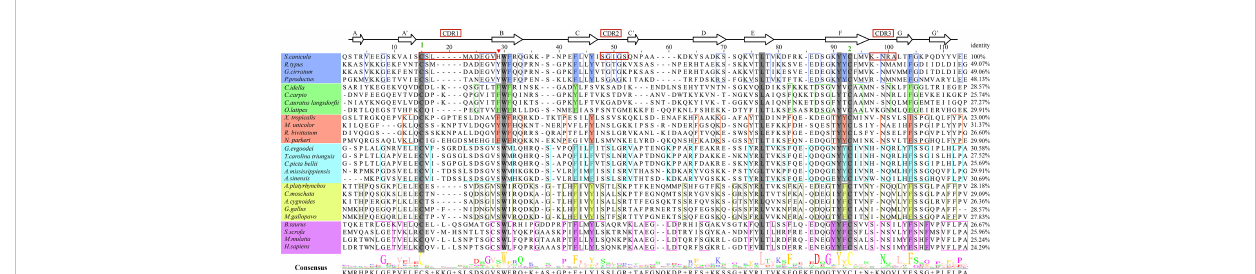
FIGURE 3 Amino acid sequence alignment of Sc CD8 a with CD8 a s from different vertebrate species, with secondary structure elements indicated. Black arrows above the alignment indicate b -strands. Green numbers denote cysteines that form disul fi de bonds, CDRs are outlined with red boxes. The residues conserved in the sampled species are shaded gray. The aa residues conserved in speci fi c vertebrate lineages are marked with colored boxes. The hydrophobic core or predicted core are highlighted with colored rectangles. Amino acid identities between Sc CD8 a and the listed CD8 a molecules are shown at the end of each sequence. The consensus sequence is shown at the bottom of the alignment. His28 in ScCD8 a IgSF V domain is indicated by “ ▾ ”